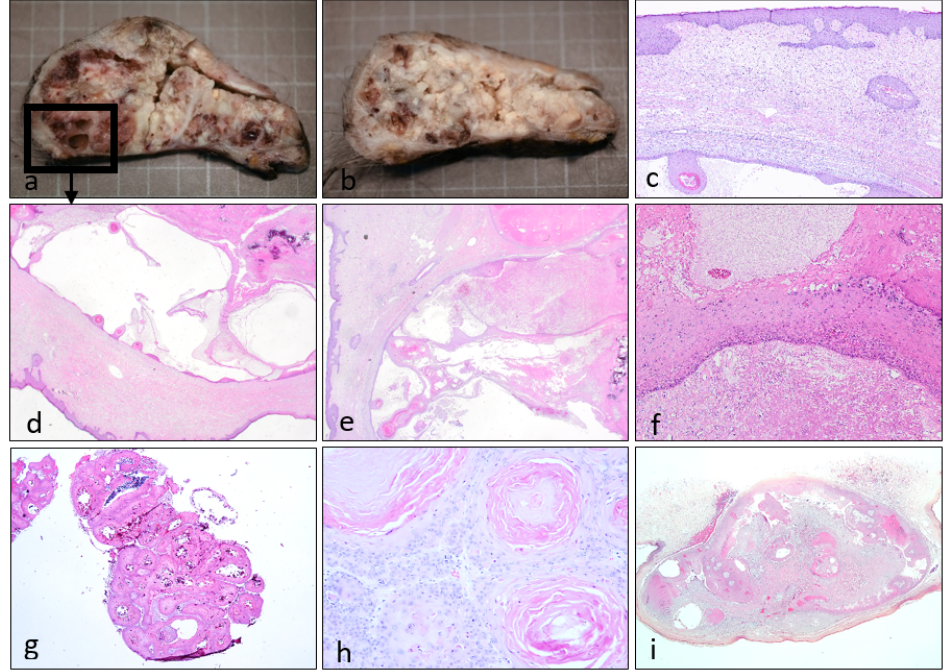
Figure 2. Correlation between macroscopic aspect after fixation and histological images. On the giant lesion (Case 1, a – f ) was appreciable the multiloculated aspect, alternating whitish keratotic content and more solid lesions ( a , b ). Histologically the lesion presented a hyperplastic epidermis and an underlying cystic lesion with epithelial endophytic projections and anastomosing epithelial strands ( b – e ); image “d” corresponds to the macroscopic lesion marked in image “a”. On some areas trichilemmal epithelium (left side) presented focally a prominent granular layer (right side), with compact keratinization and parakeratosis ( f ). Histologic findings were variable, with marked calcification and minor keratin content (Case 5, g ). In the solid areas maturation was preserved, with reactive changes and minor inflammation (Case 3, h ). Tumoral silhouette generally revealed a sharply defined cystic lesion, with proliferation towards the interior of the cyst (Case 2, i